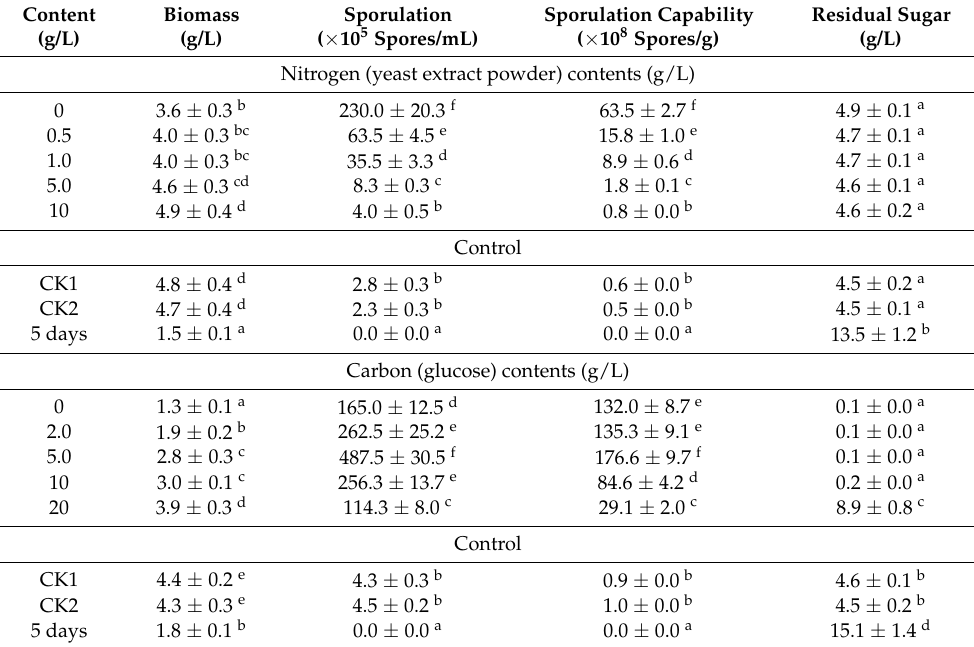
Table 3. Effect of different nitrogen and carbon contents on the conidiation of A. cinnamomea . Content